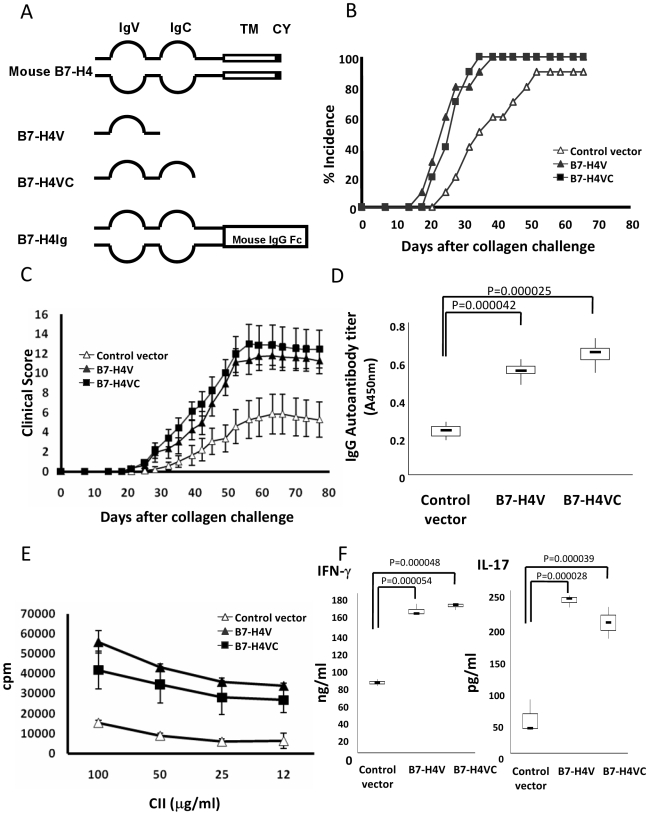
sH4 exacerbates disease in CIA model.(A) Schematic representation of the full length murine B7-H4, B7-H4V, B7-H4VC, and B7-H4Ig fragments, which were inserted into pcDNA plasmid. IgV, immunoglobulin V-like region; IgC, immunoglobulin C-like region; TM, transmembrane region; CT, cytoplasmic tail. Effect of decoy B7-H4 in incidence (B) and (C) clinical score of CIA. Mice were immunized with CII in complete Freund's adjuvant (CFA) on day 0 and day 21. The incidence and clinical score were recorded daily based on the standard described in Materials and Methods. Three groups of mice were injected with the indicated plasmids on day −1 and day 20. Each point represents results from pool of ten mice and expressed as means ± 95% confidence interval. Data represent three independent experiments. Statistical analysis was performed by repeated ANOVA method (p<0.0001). The following Tukey-Kramer test showed significant differences at each points after day 28 between the control group and other two groups (p<0.01). (D) Effect of decoy B7-H4 in the generation of autoantibodies against CII in CIA sera. CIA mice were treated with indicated plasmids and sera were sampled at day 30 after collagen immunization. Serum levels of IgG against CII were determined by specific ELISA as described Materials and Methods. Each group represents results from a pool of five mice. The top and bottom of each rectangular box denotes the 75th and 25th percentiles, respectively, with the median shown inside the box. Error bars extending from each box represent the maximum and minimum. Data represent three independent experiments. Statistical analysis was performed by ANOVA method followed by the Scheffé test. (E) Effect of decoy B7-H4 in the proliferation of T cells reactive to collagen in CIA mice. CIA mice were first treated with indicated plasmids in vivo as indicated in (B). Whole splenocytes from the mice at day 30 after collagen immunization were cultured in the presence of the indicated concentrations of CII for 72 h. The cultures were pulsed with 3HTdR 18 h before harvest, and cpm were determined by a scintillation counter. Each point represents results from three wells and data represent two independent experiments and expressed as means±95% confidence interval. (F) Effect of decoy B7-H4 in the production of cytokines from splenocytes reactive to CII in CIA mice. Supernatants in splenocyte cultures as described in (E) at 72 h were collected and assessed for IFN-γ and IL-17 by ELISA. Each group represents results from three wells and data represent three independent experiments. The top and bottom of each rectangular box denote the 75th and 25th percentiles, respectively, with the median shown inside the box. Error bars extending from each box represent the maximum and minimum. Statistical analysis was performed by ANOVA followed by the Scheffé test.